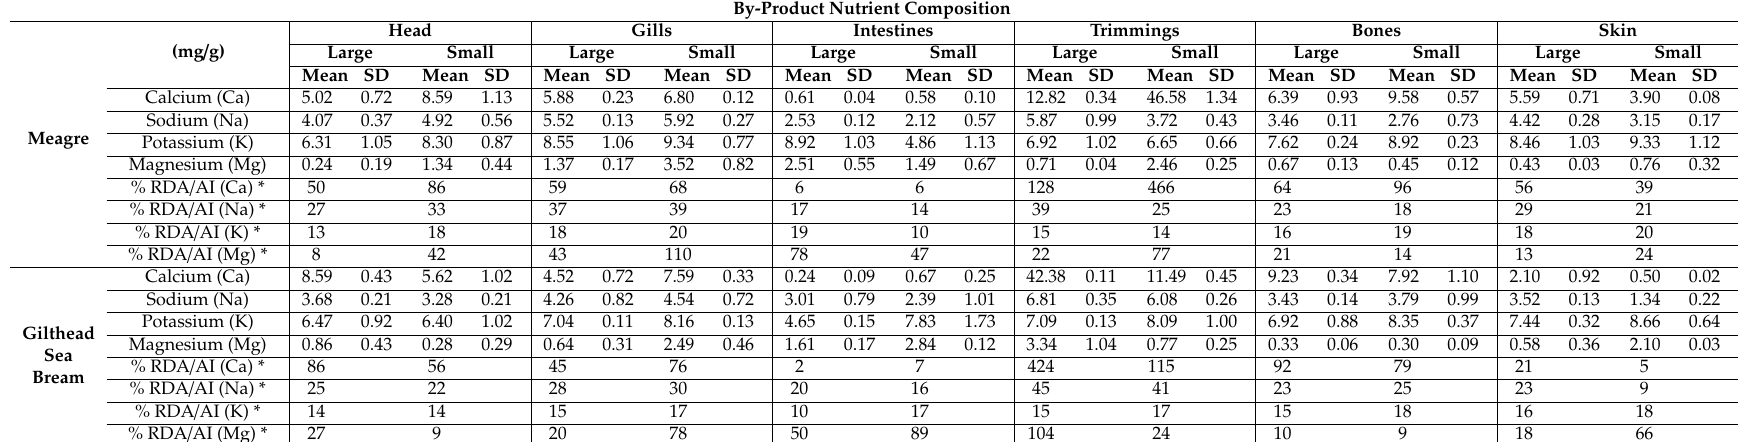
Table 3. Data of mineral composition of by-product samples (head, gills, intestines, trimmings, bones, skin) of meagre and gilthead sea bream fishes in two di ff erent size classes (large and small) and the RDA and AI